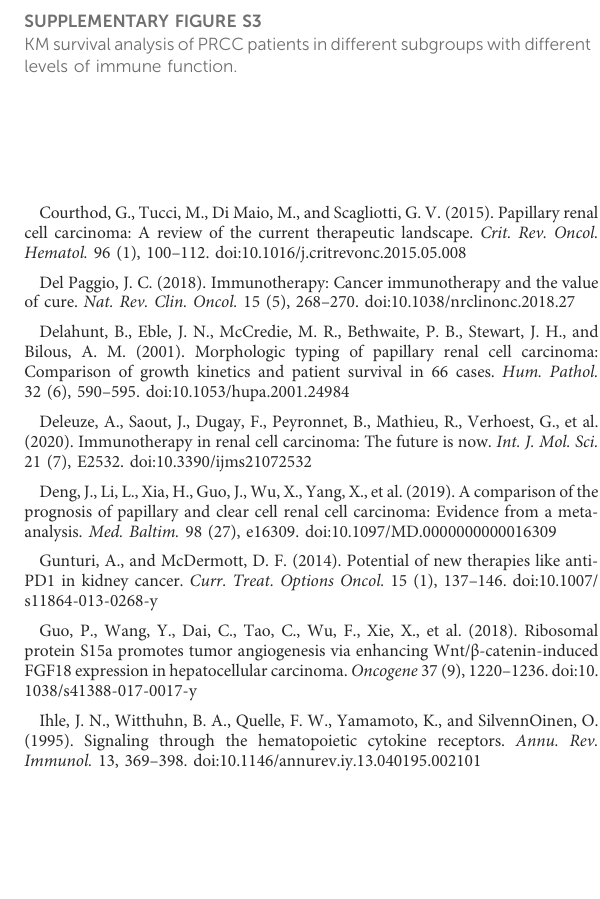
SUPPLEMENTARY FIGURE S1 The correlation of the in fi ltrating immune cells with the IRGPI. SUPPLEMENTARY FIGURE S2 KMsurvivalanalysisofPRCCpatientsindifferentsubgroupswithdifferent levels of immune cell in fi ltration. SUPPLEMENTARY FIGURE S3 KMsurvivalanalysisofPRCCpatientsindifferentsubgroupswithdifferent levels of immune